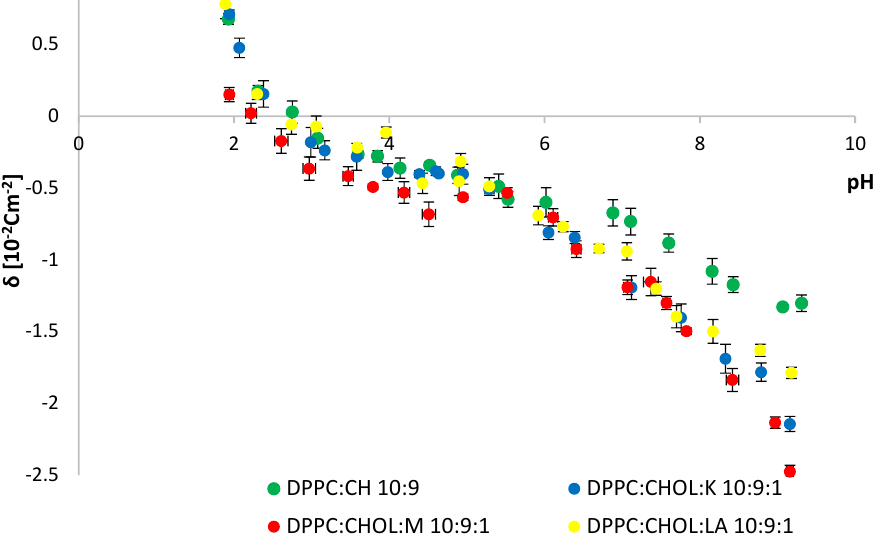
Figure 7. Membrane surface charge densities vs. the pH of the electrolyte solution for (DPPC:CHOL),